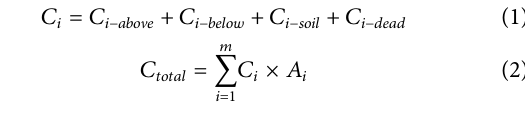
Frontiers in Earth Science |